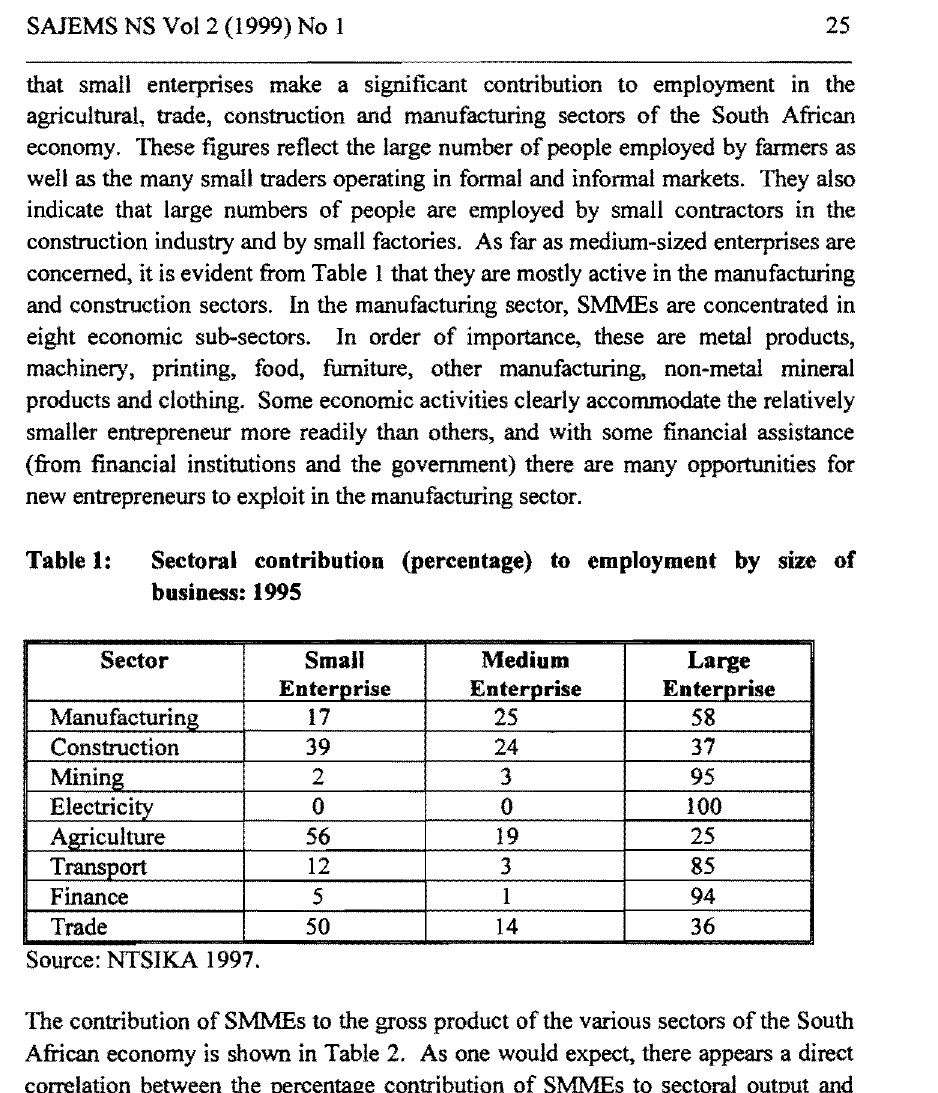
Sectoral contribution (percentage) to employment by size of business: 1995 Sector Small Medium Large Enterprise Enterprise Enterprise Manufacturing 17 25 58